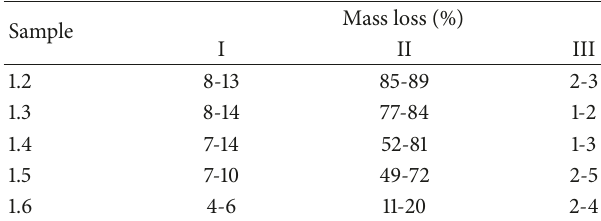
Table 3: The range of mass losses of coal samples at three reaction